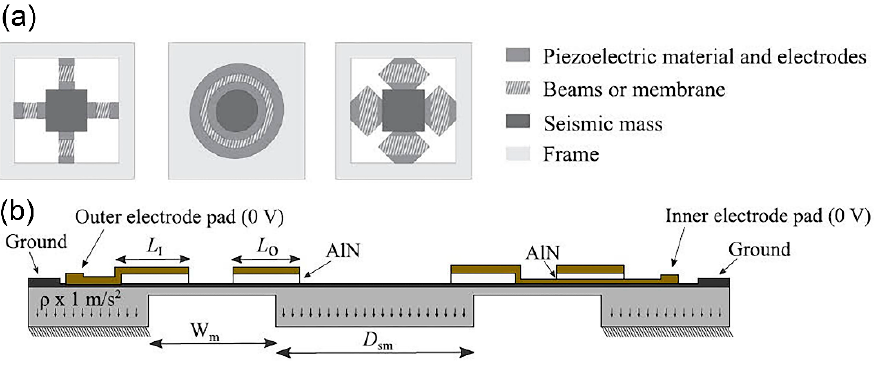
Figure 25. ( a ) Top view of the trampoline (left), annular (middle) and hexagonal beams with square seismic mass (right) piezoelectric accelerometers. ( b ) The geometric parameters, boundary conditions and body force imposed in the finite element model, represented in a sectional view of the annular accelerometer [89].